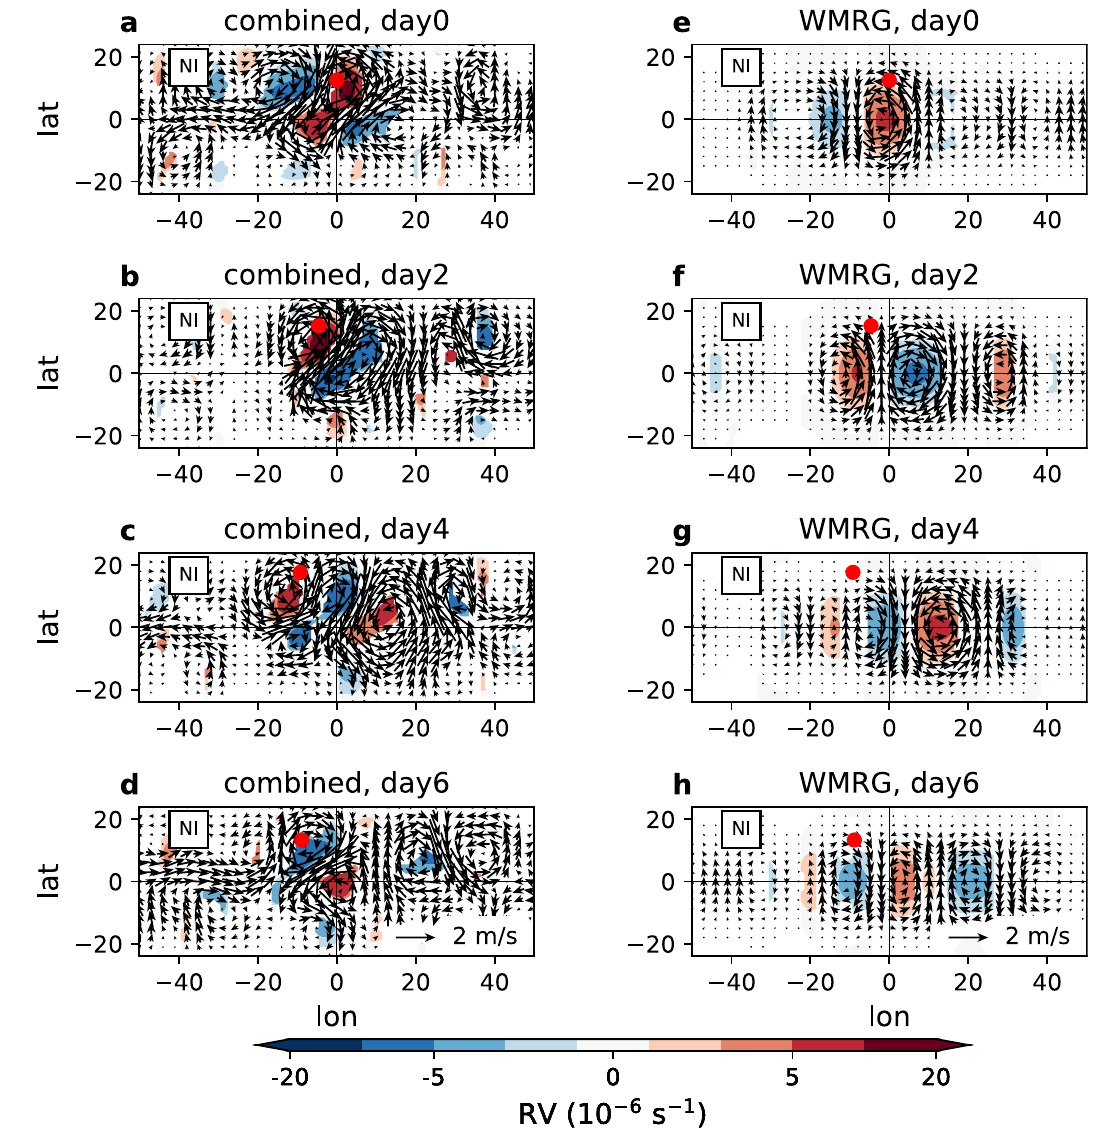
Fig. 6 | Effect of equatorial waves on pre-tropical cyclone (pre-TC) intensity in the North Indian Ocean (NI). a Composite means of combined wave horizontal winds (vectors) and relative vorticity (RV, in the units of 10 − 6 s − 1 ; shading) in the lower troposphere onto pre-tropical cyclogenesis (pre-TCG) events that are simultaneouslymatchedin-phasetoWestward-movingMixedRossby-Gravitywave (WMRG),modenumber1 Rossby wave (R1)and modenumber 2Rossby wave (R2), with respect to the vortex longitude and event time of pre-TCG, in the NI. Only